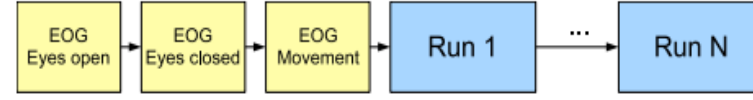
Figure 1. Timing scheme of one session.